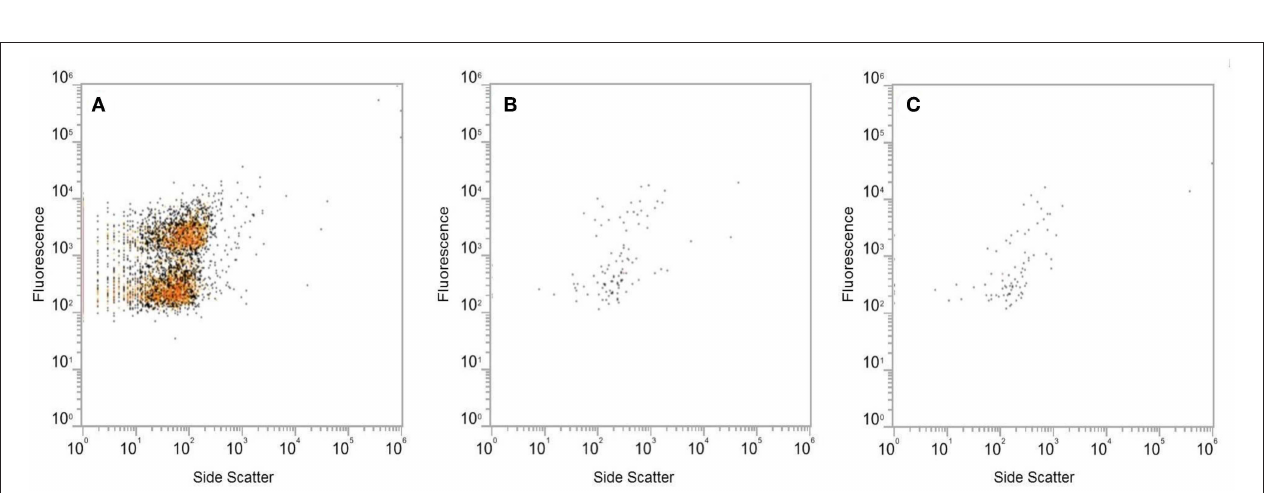
FIGURE 3 | Analysis of the SYBR Green I-stained extracted VLP fraction by flow cytometry, using fluorescence and side scatter as metrics. Level of fluorescence differentiated two populations of VLPs in the extracted VLP fraction (A) . The fluorescent signal produced by the flow through from Amicon Ultra 100 kDa filters (B) was at the same level as the PBS blank (C)